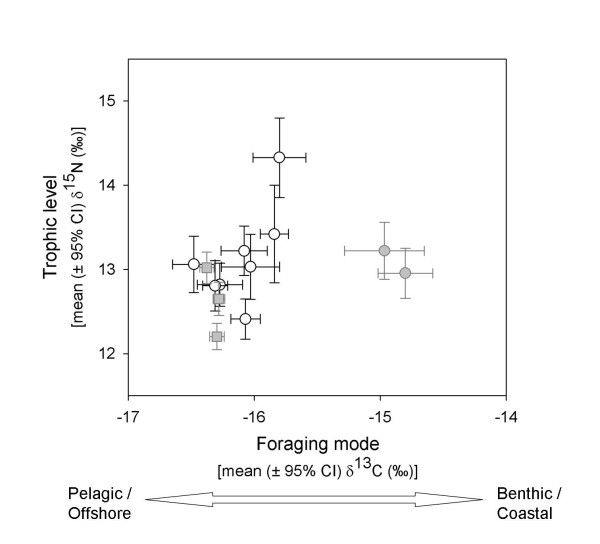
Isotopic biplot showing mean (± 95% CI) of δ13C and δ15N values from juvenile Galápagos sea lions (circles) and Galápagos fur seals (square) collected in different rookeries across the Galápagos Islands. The corresponding habitat of each rookery is indicated by colour (white = Centre, grey = West).